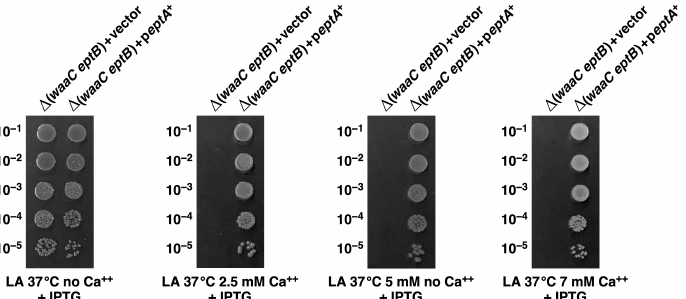
Figure 10. Overexpression of the eptA gene restores the growth of ∆ ( waaC eptB ) strains in Ca ++ - supplemented media. Exponentially grown cultures of ∆ ( waaC eptB ) carrying either the vector alone or the plasmid with the inducible expression of the eptA gene were adjusted to an OD 595 of 0.1 and serially spot diluted at 37 ◦ C in LA agar, either supplemented with varying concentrations of CaCl 2 , or without supplementation with CaCl 2 , as indicated. Plates were incubated for 24 h, and the data presented are from one of the representative